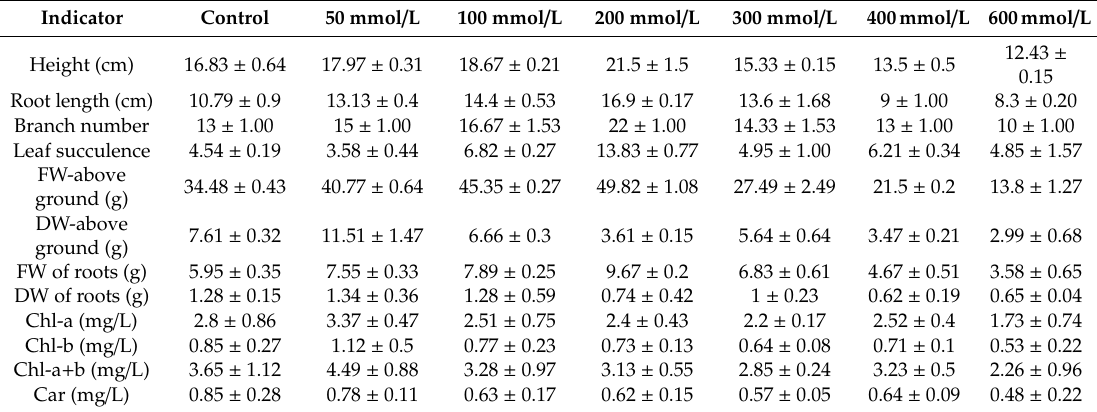
Table 3. Physiological indicators for Suaeda salsa (statistics with means ± standard